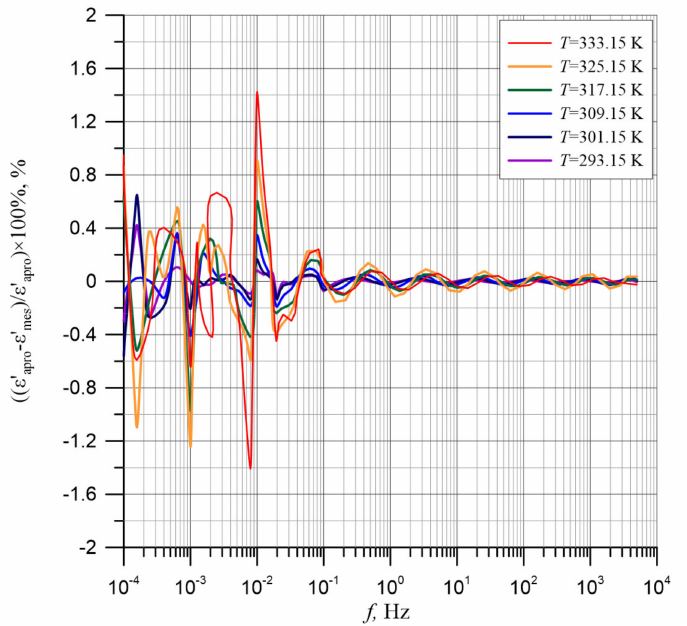
Figure 4. Permittivity differences between the permittivity test results for the composite of cellulose, transformer oil and water nanoparticles for temperatures from 293.15 to 333.15 K and calculated polynomial